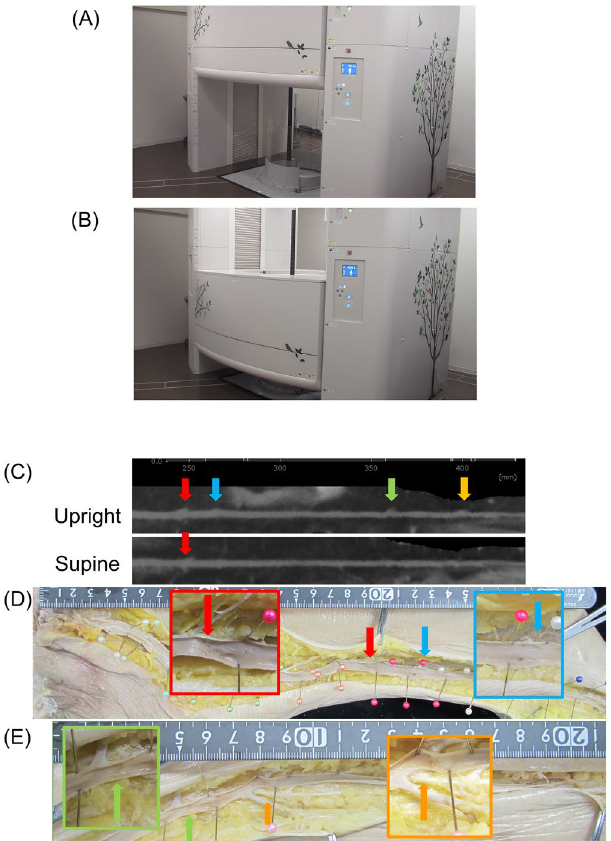
Figure 1. An overview of upright CT and CT images of raw cadaver lower extremities and anatomical analyses after being fixed with formaldehyde. ( A ) Gantry in the up position. ( B ) Gantry in the down position. Subjects stand in the center of the gantry and the gantry moves up to down to scan. ( C ) MPR images of SV based on both upright CT and supine CT. Four valves (arrows) were identified in upright CT, however; some of them